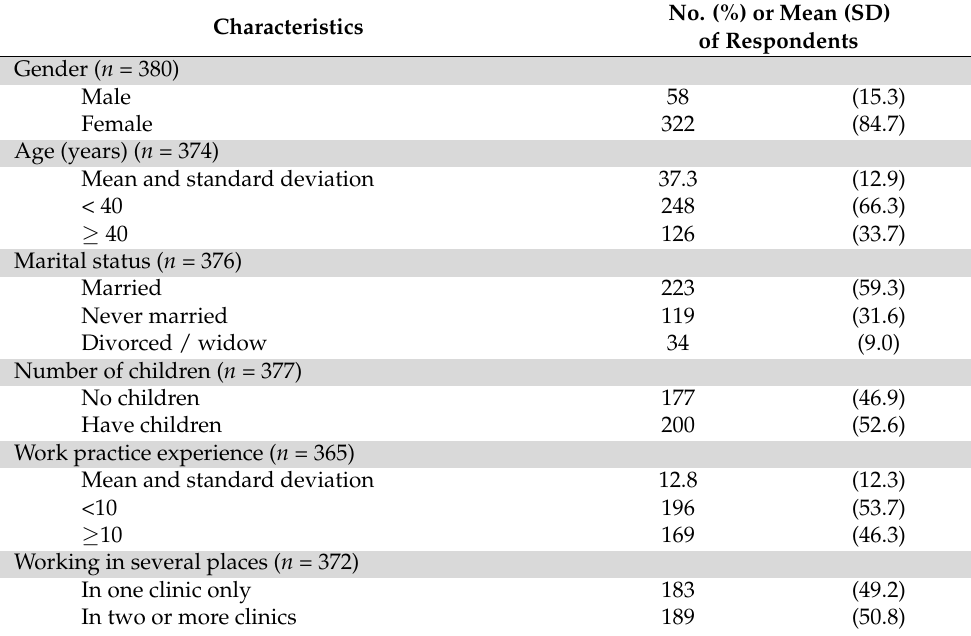
Table 1. Distribution of study participants by demographic and workload